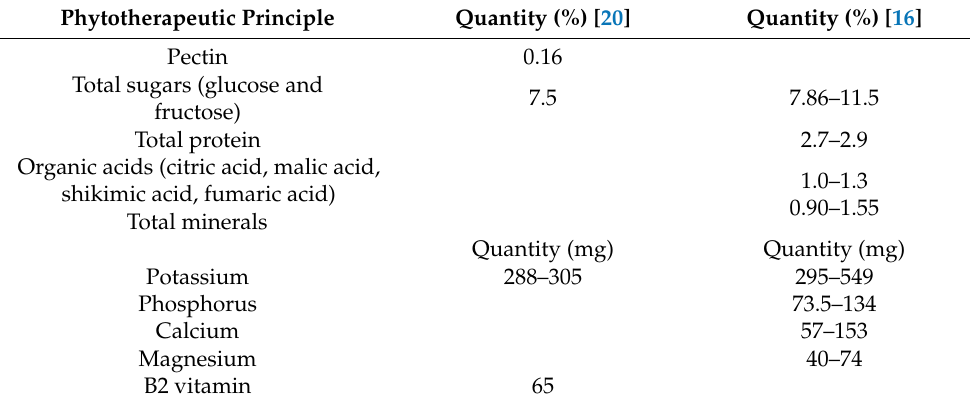
Table 1. Nutritional and phytotherapeutic principles found in 100 g of fresh